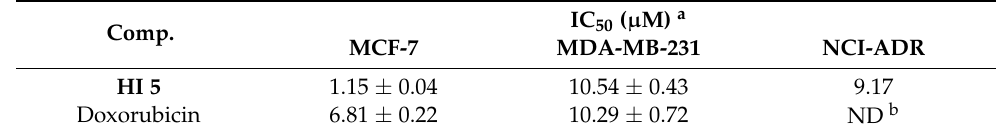
Table 3. In vitro antiproliferative activity of HI 5 against breast (MCF-7, MDA-MB-231) and ovarian (NCI-ADR) cancer cell lines.